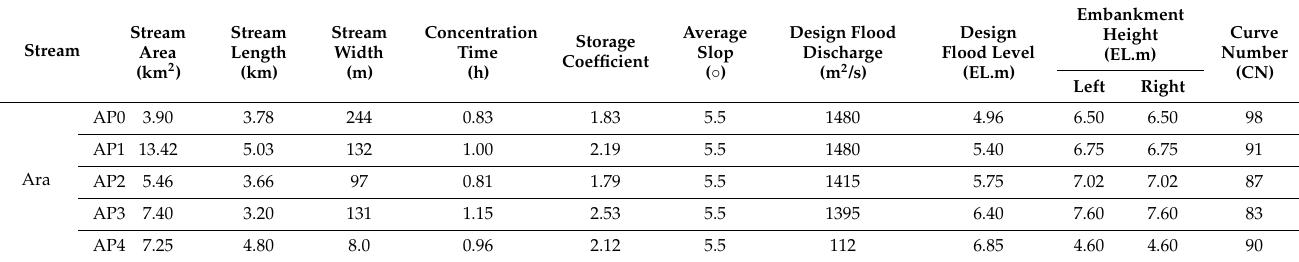
Table 1. Summary of Main Input